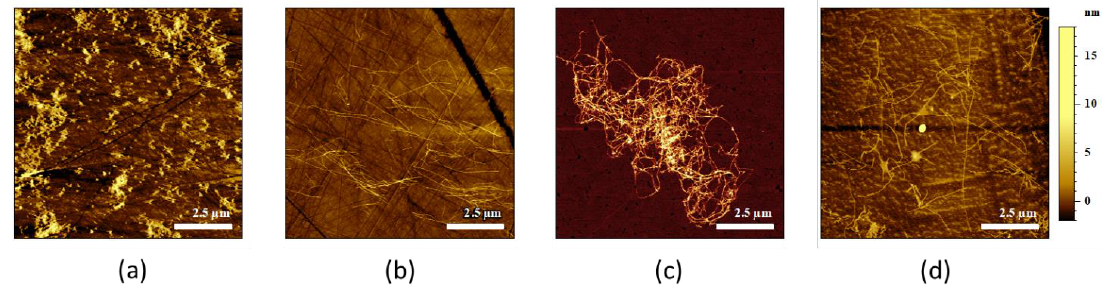
Figure 4. AFM images of Aβ42 on different substrates. ( a ) ZnSe prism, ( b ) ZnS, ( c ) Au and ( d ) diamond. We observed on the ZnSe prism amorphous aggregates, and on all the other surfaces well-deposited long amyloid fibrils.